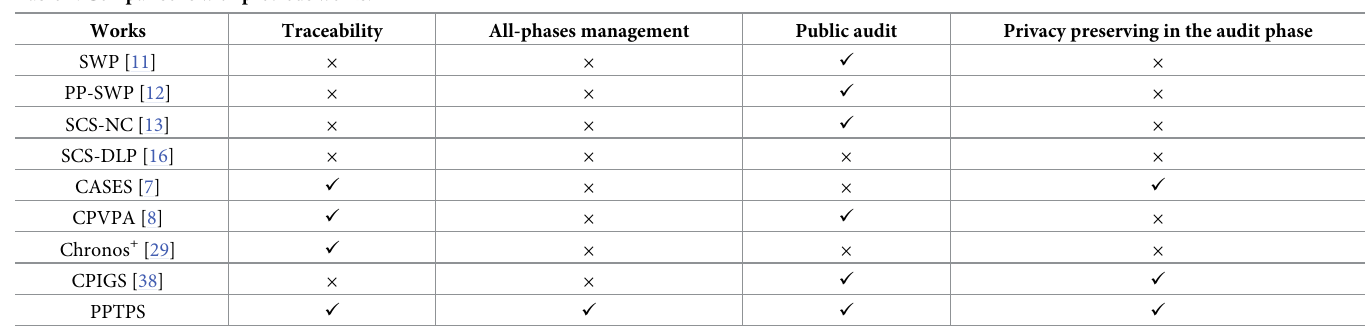
Table 1. Comparisons with previous